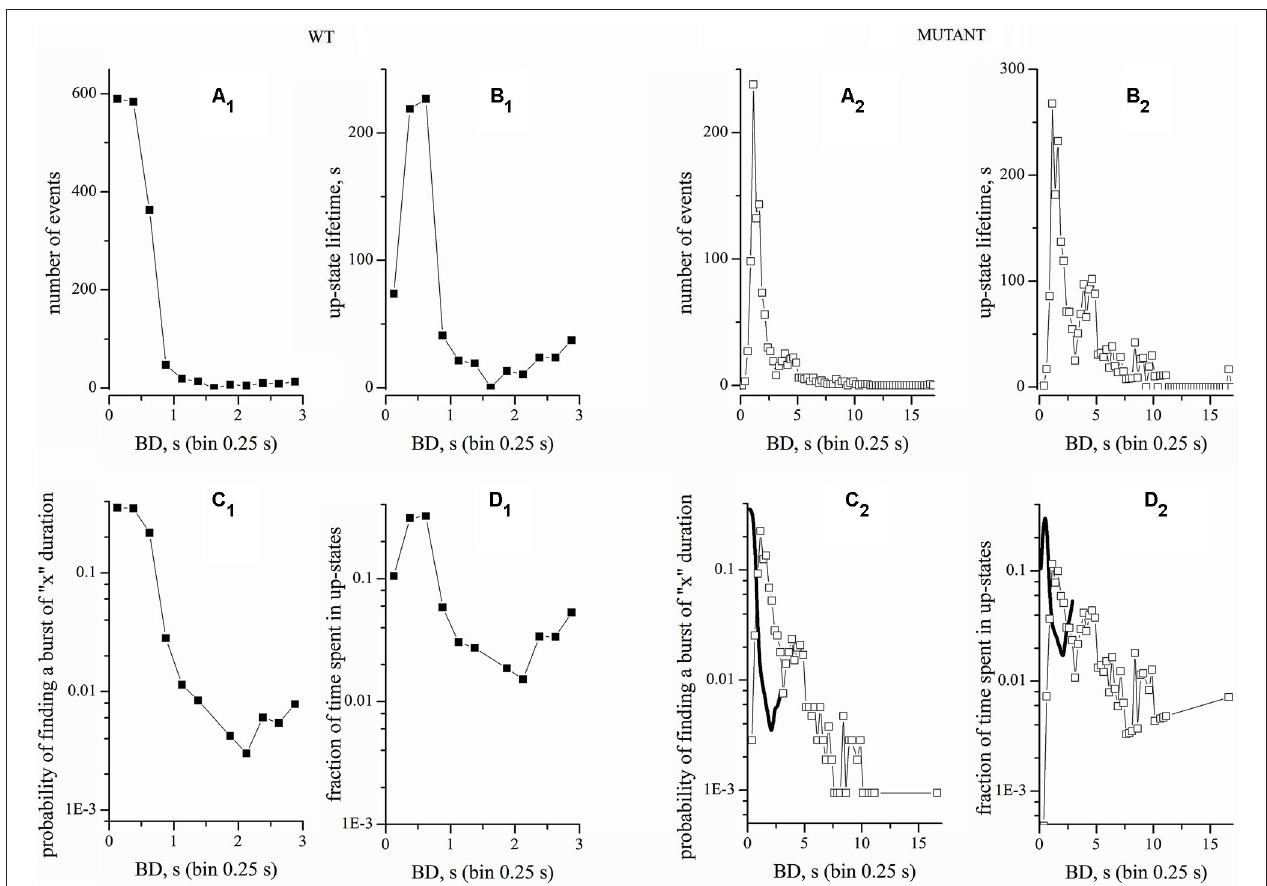
BD histograms. (D 1 , D 2 ) Fraction of time spent in up-states. In (C 2 ) and (D 2 ) , the thick lines (B-Splines) indicate the WT data. WT and Mutant experiments had durations of 9 and 4 h, respectively. The total number of bursts and the total up-state time (given within brackets) were 1661 (702 s) and 1058 (2320 s) for WT and Mutant experiments,